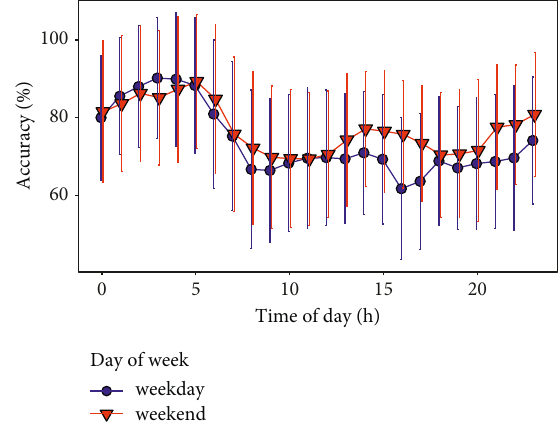
Figure 10: The prediction accuracy at different times of the